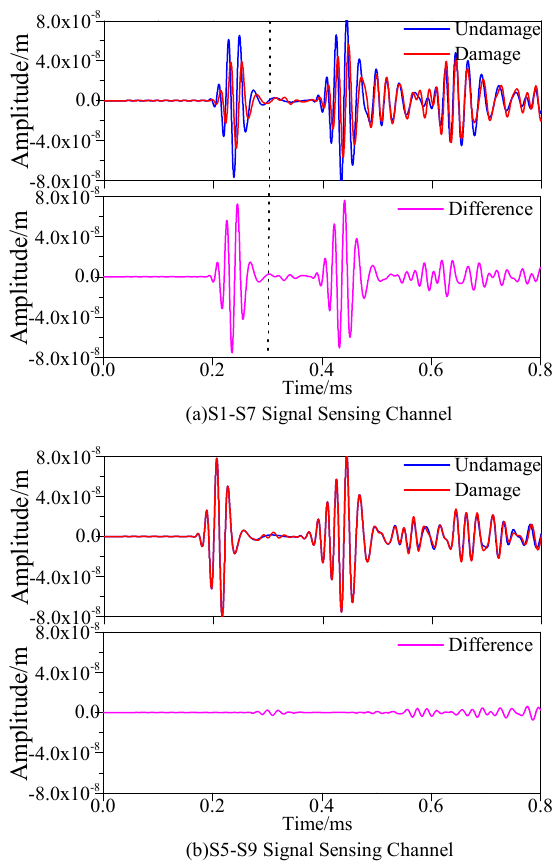
Figure 5. Response signals with different sensing channels. ( a )S1–S7 Signal Sensing Channel ( b )S5–S9 Signal Sensing Channel.